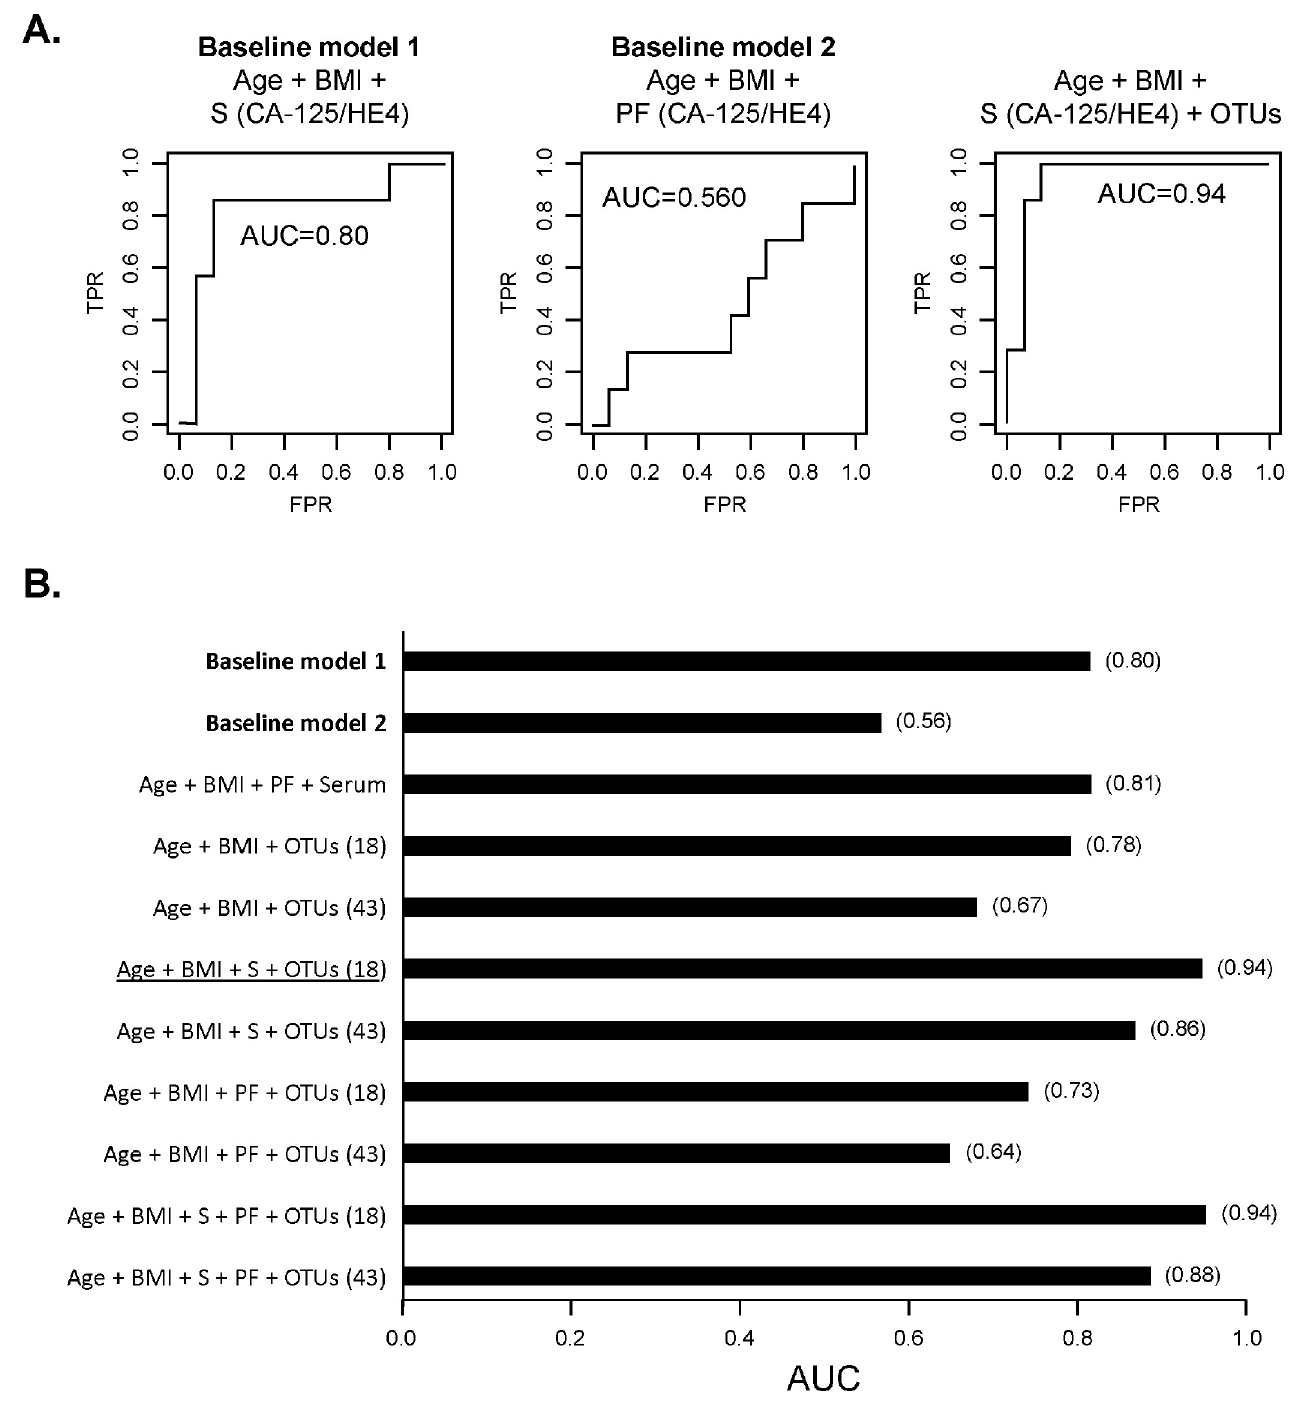
Fig 5. AUC Analysis of models for OC diagnostic potential. A. AUC calculations for the baseline models 1 and 2 (left and middle panels, respectively) and after adding the 18 top ranked OTUs to baseline model 1 (right panel). B. Summary of AUC values obtained for baseline models and various feature combinations (S: serum; PF: peritoneal